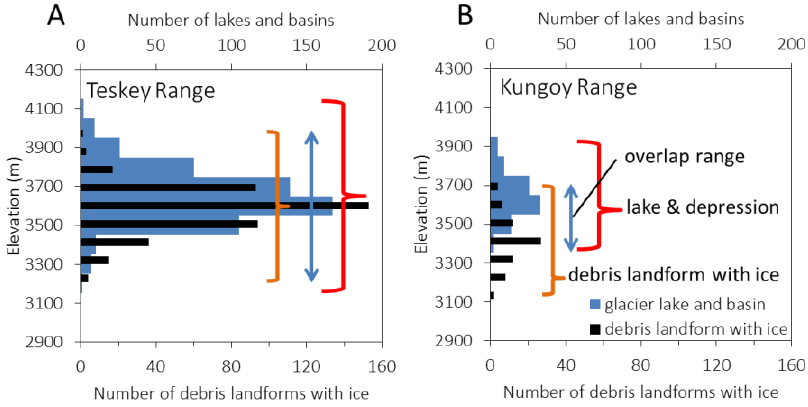
Figure 8. Elevation ranges for the zones of glacial lake depressions and debris landforms with buried ice in the Teskey ( A ) and Kungoy ( B ) Ranges.